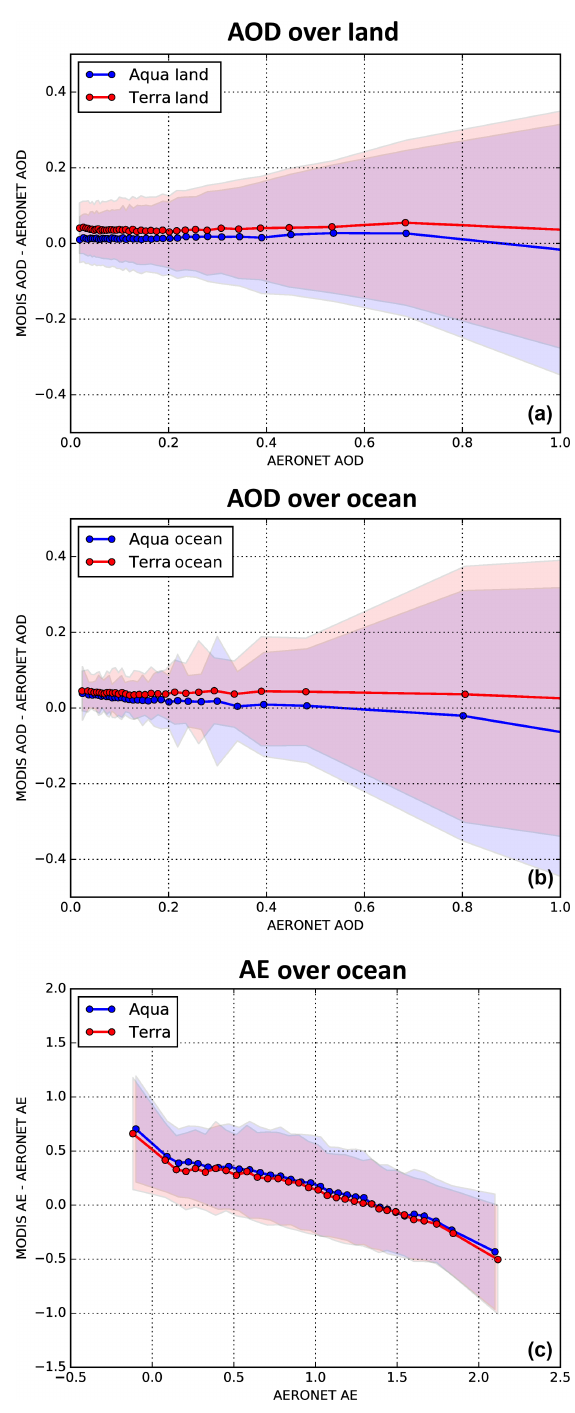
Figure 2. Statistics of MxD04–AERONET difference as a func- tion of AERONET values for AOD (0.55µm) over land (a) and ocean (b) , and for AE over ocean (c) . For each panel, data from MOD04 (MYD04) are plotted in red (blue). For each sensor, the dots (and connecting lines) represent the mean of the MxD04– AERONET difference, whereas the shaded area represents the mid- dle ± 1 σ of the difference. Note that each MxD04 is compared sep- arately to AERONET and that the AERONET data are ordered into bins with an equal number of points.